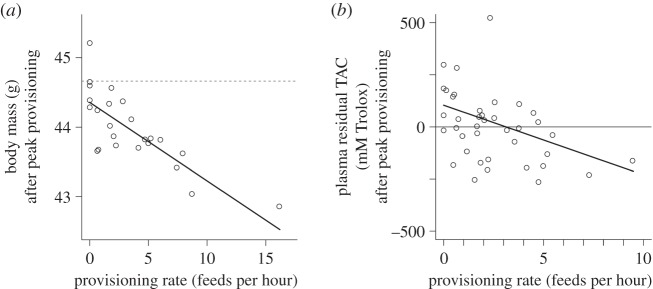
(a) The effect of natural variation in individuals' provisioning rates on their body mass at peak provisioning. Birds provisioning at a higher rate subsequently had a significantly lower body mass at peak provisioning, while controlling for the effects of individual variation in body mass at clutch completion and dominance/sex status (see Results). The solid line represents the prediction from a mixed effects model containing clutch completion mass and provisioning rate as predictors, and social group ID as the random effect. The predictions are for an individual of mean clutch completion body mass (44.66 g—indicated by the dotted line) and the points represent residuals from this model (n = 24 birds from 11 social groups). (b) The effect of natural variation in individuals' provisioning rates on their plasma residual TAC at peak provisioning. Birds provisioning at a higher rate subsequently had lower plasma residual TAC. The diagonal solid line represents the model predictions from a mixed effects model in which provisioning rate was the only predictor and social group ID the only random effect, and the points represent residuals from this model (n = 39 birds from 15 social groups).